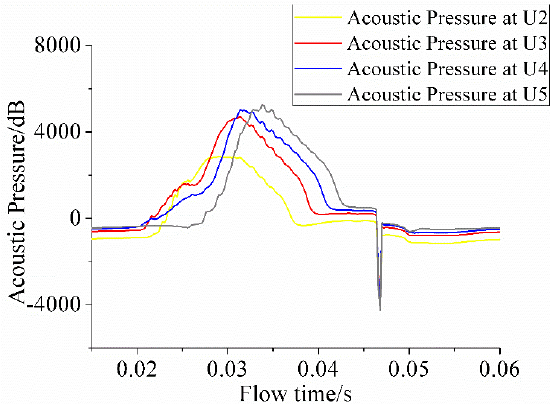
Figure 16. Acoustic pressure pulsation at different locations for σ = 0.65.